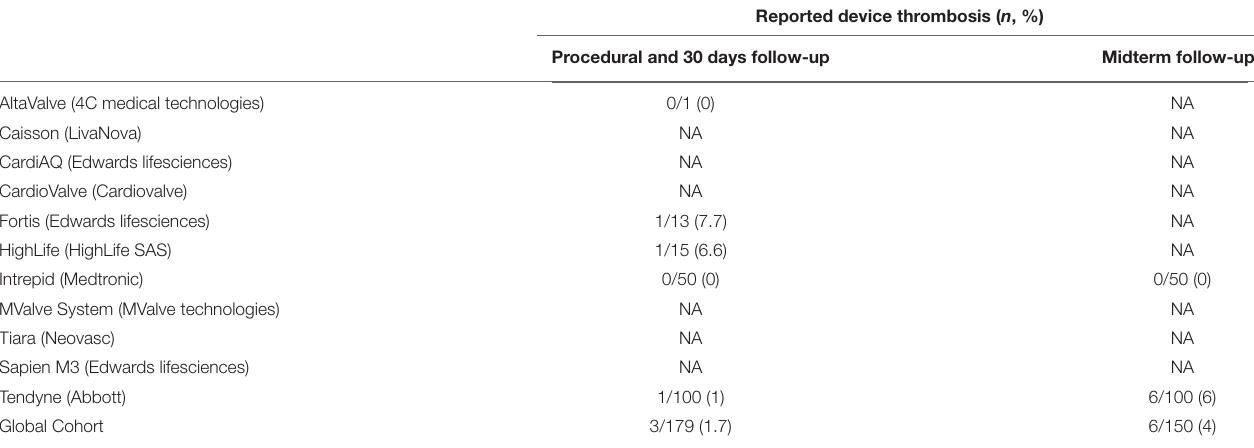
TABLE 1 | Available data on thrombotic risk of currently developed devices for TMVR in native mitral valve disease (3).